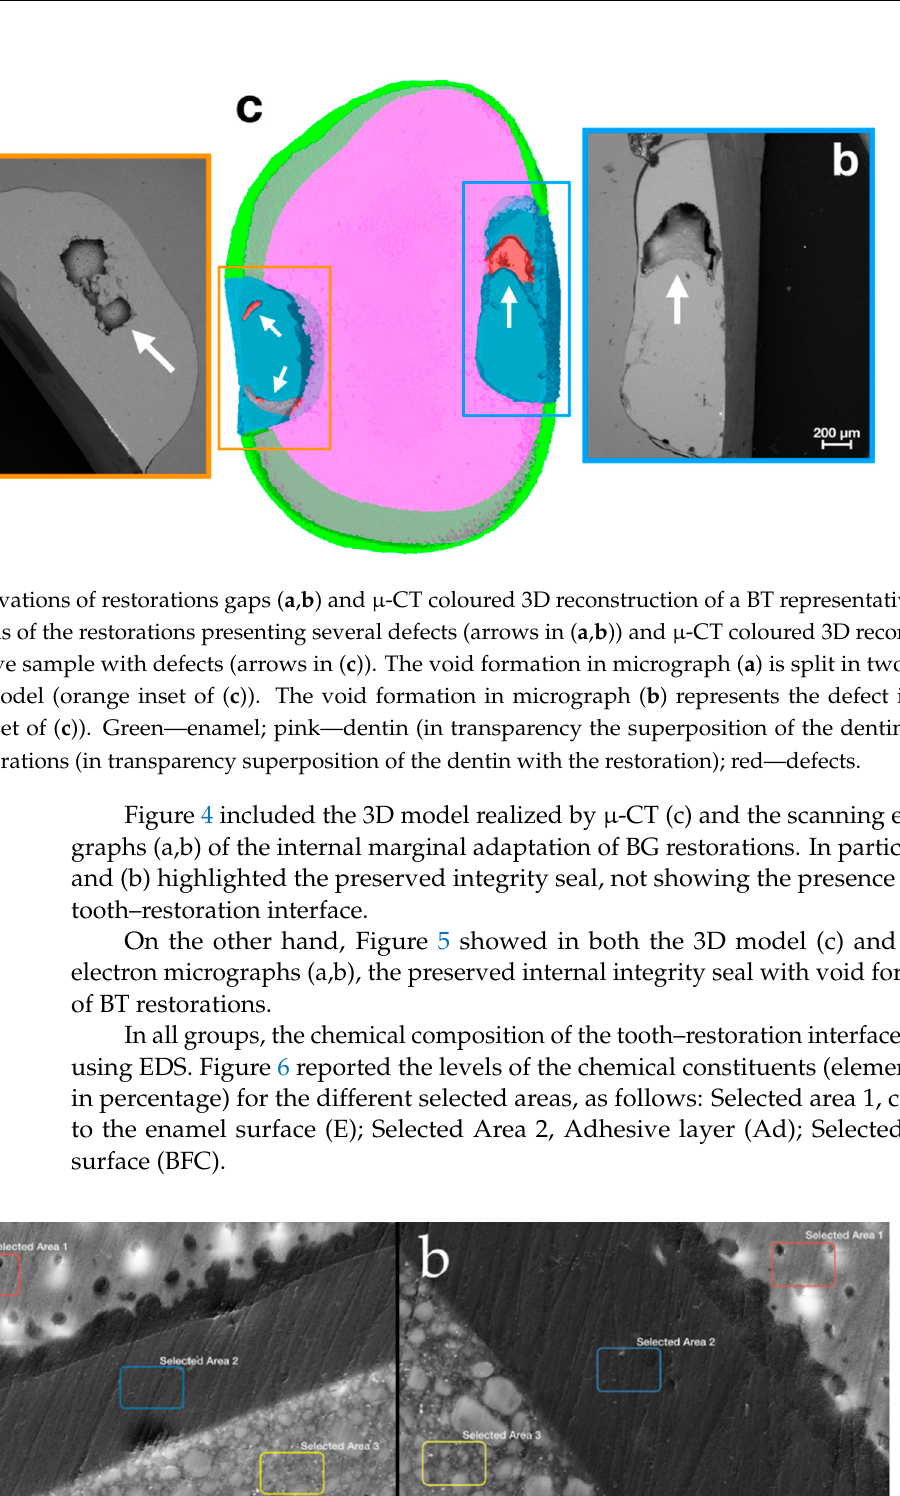
Figure 4. SEM observations of restorations gaps ( a , b ) and µ-CT colored 3D reconstruction of a BG representative sample ( c ). Green—enamel; pink—dentin (in transparency the superposition of the dentin with the enamel); blue—restorations.